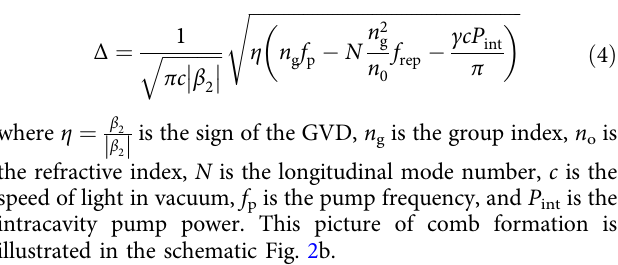
the output to a high-speed photodetector. The comb spacing is